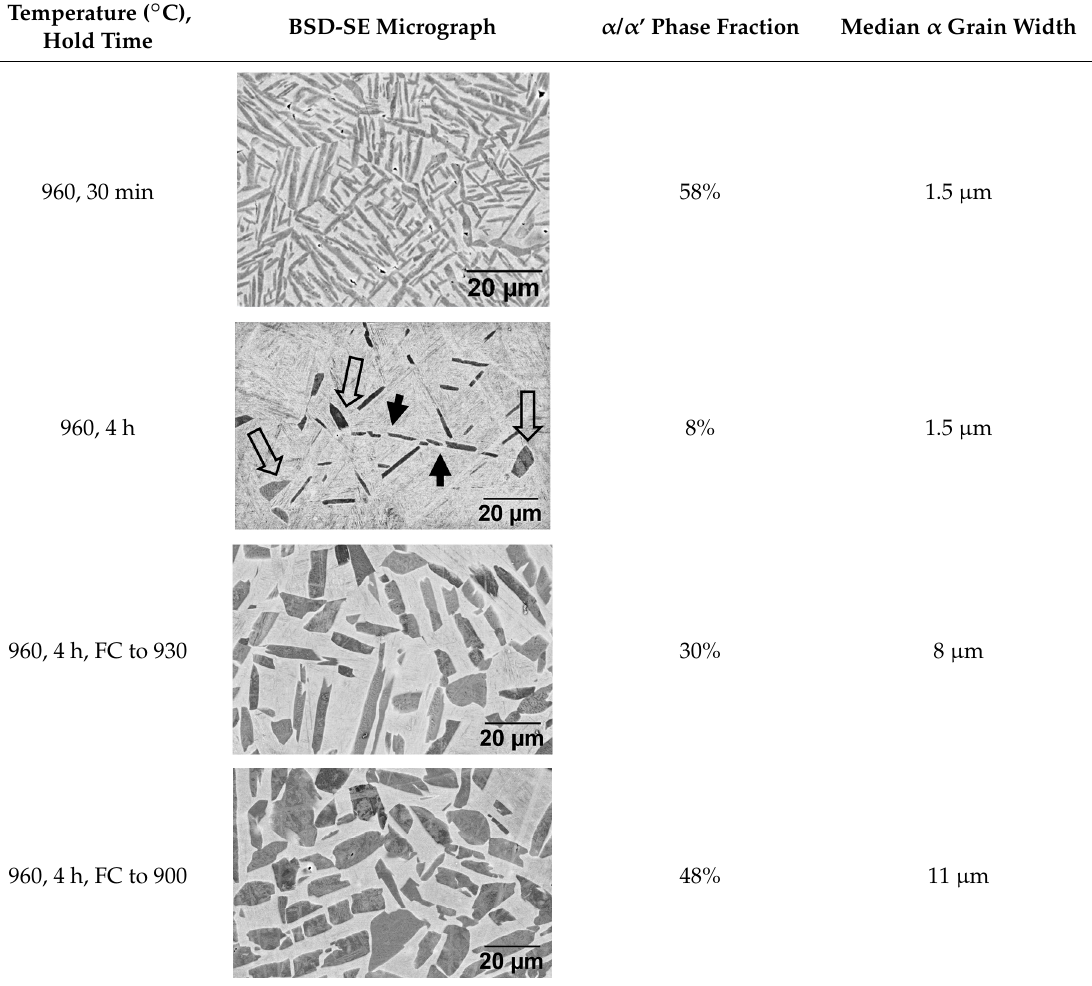
Table 7. Microstructure—annealing at 960 °C.